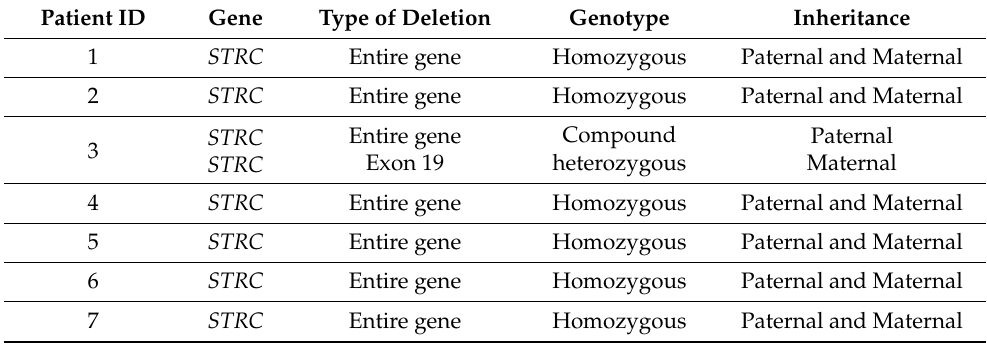
Figure 1. Schematic representation of the multistep and integrative approach performed in this study. One-hundred and two patients affected by HHL and negative in GJB2 , GJB6 , and MT-RNR1 screening underwent a detailed clinical examination (1) aimed to differentiate NSHL patients from SHL ones. The patients affected by NHSL were screened for deletions in the STRC-CATSPER2 and OTOA genes (2). For the NSHL patients carrying a heterozygous deletion of STRC with a typical audiometric pattern, STRC sequencing was performed. WES was carried out in all NSHL patients negative for these steps and in SHL patients. Created with BioRender.com (accessed on 25 January 2023). Table 1. STRC deletions identified through MLPA analysis. Gene: gene carrying the deletion. Type of deletion: entire-gene deletion or specific exon(s) deletion. Genotype: homozygous: the same variant is present on both alleles; compound heterozygous: two different variants are present on each allele. Inheritance: inheritance pattern of the deletion established after parental